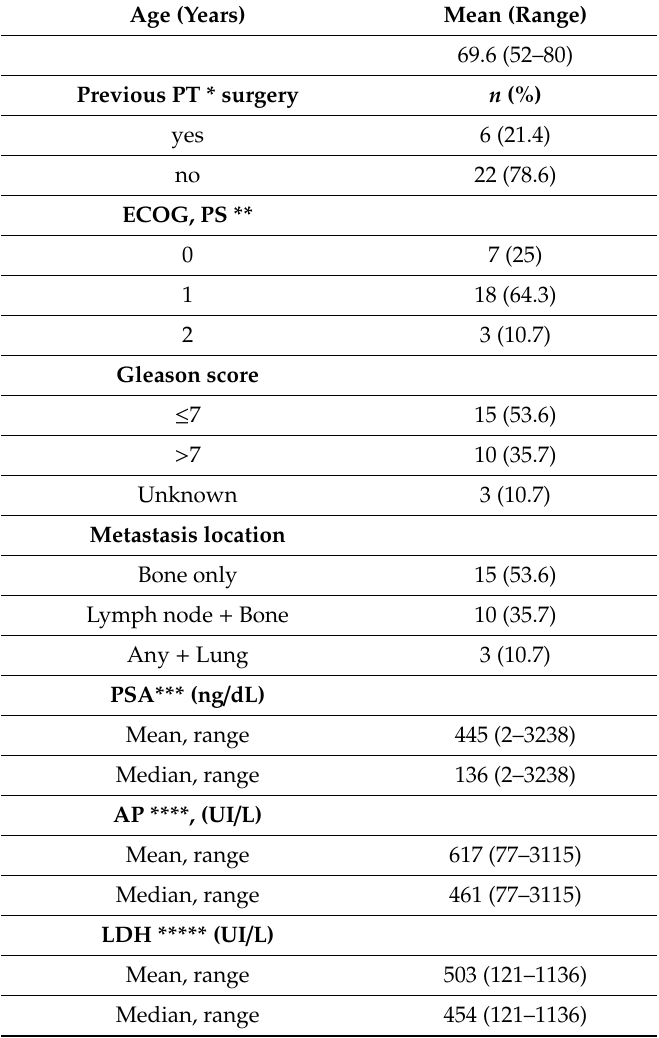
Table 1. Clinical parameters of the metastatic castration-resistant prostate cancers (mCRPC)